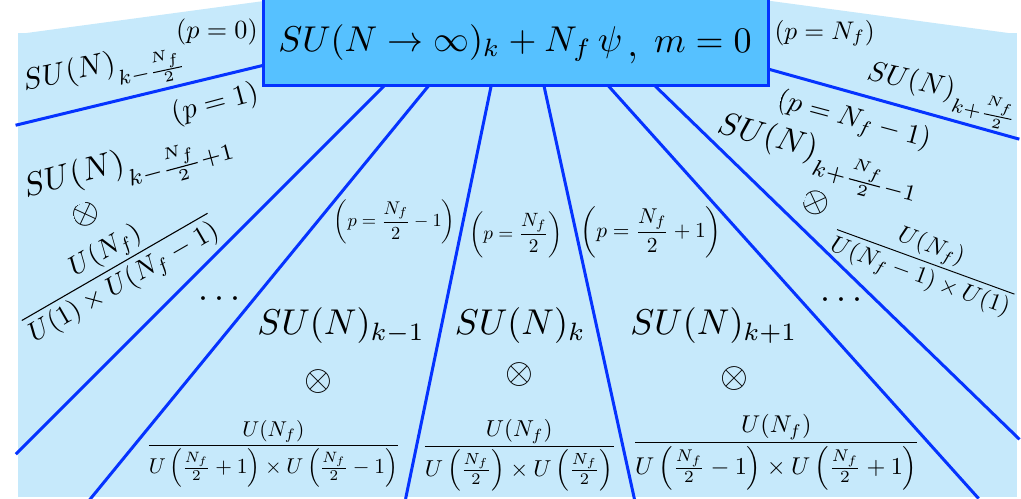
Figure 5 . Degenerate superselection sectors of massless QCD 3 in the N ! 1 limit. For each sector we indicate the integer p appearing in (2.33), the low-energy Chern-Simons TQFT, and the target space for the NG bosons (i.e. the (cid:13)avor-symmetry breaking